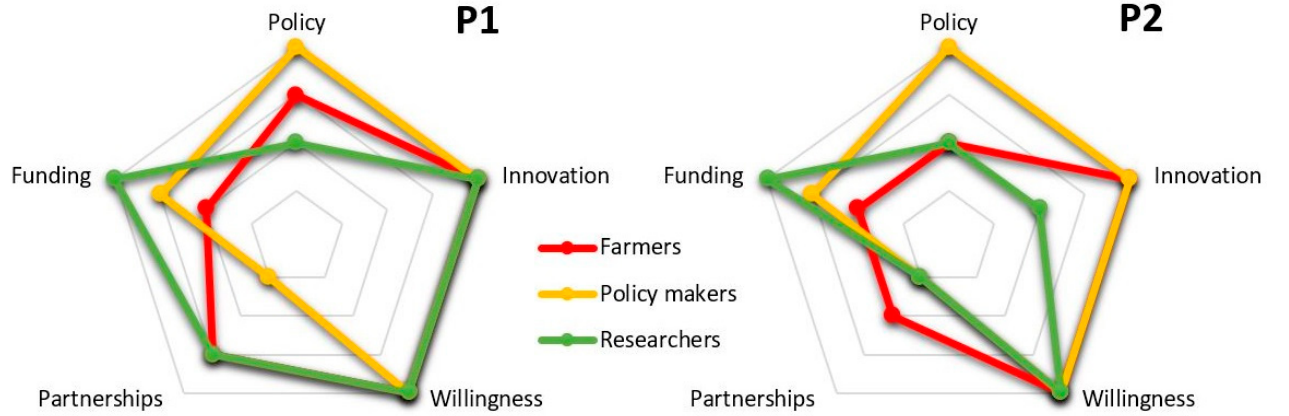
Figure 4. Main facilitators for adopting sustainable practices by group. P1 (harvesting and storage of rainwater, practice 1); P2 (desalination of seawater, practice 2).